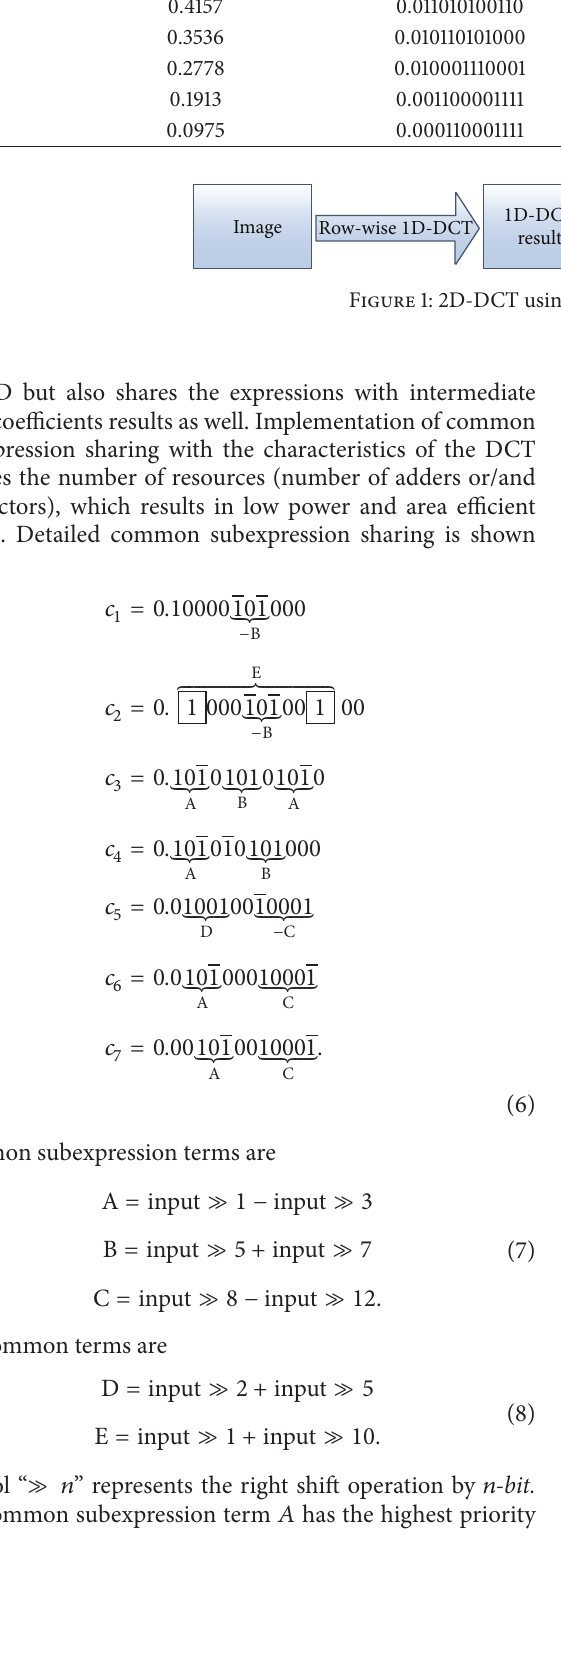
Table 2: 12-bit precise DCT coefficient in CSD form and reduction of nonzero bits.